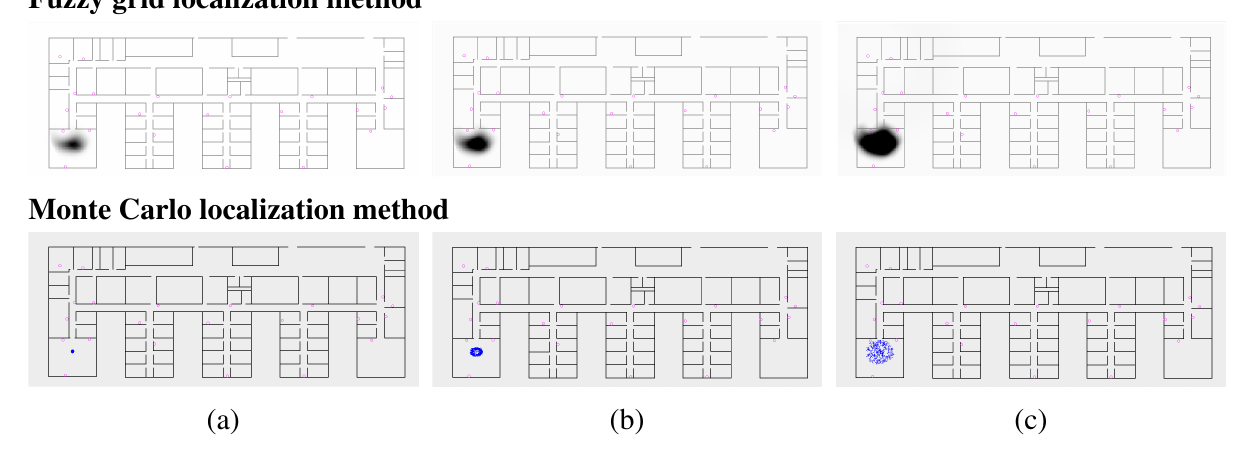
Figure 2. Example of action model (prediction phase) of the fuzzy grid (upper) and Monte Carlo (lower) localization